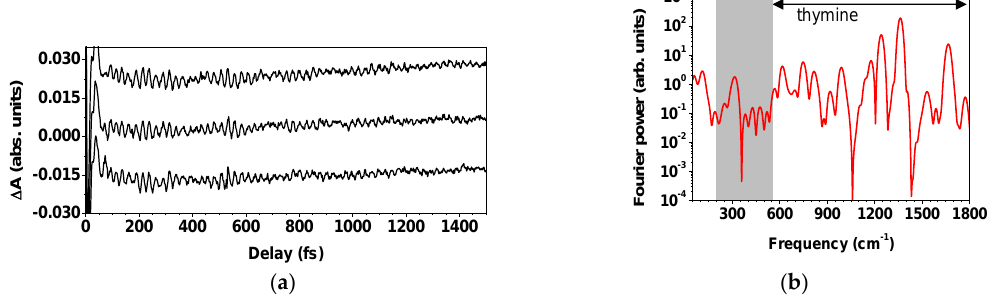
Figure 10. ( a ) Measured transient absorption signals as a function of the pump-probe time delay; ( b ) The Fourier transform of a typical transient absorption signal. The gray shaded part in ( b ) shows the signals that originate from other components than thymine.